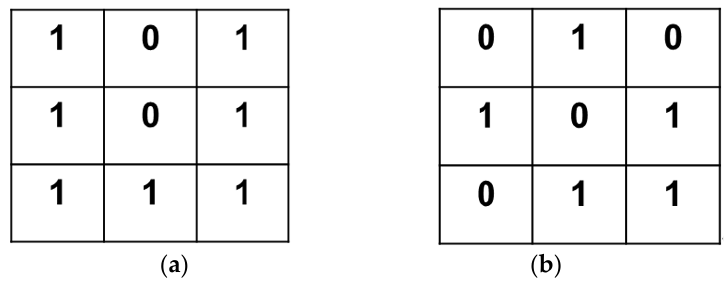
Figure 20. Test results: ( a ) branch point; ( b ) vertex point. When the center point of the template was 0, it meant that this point was valid